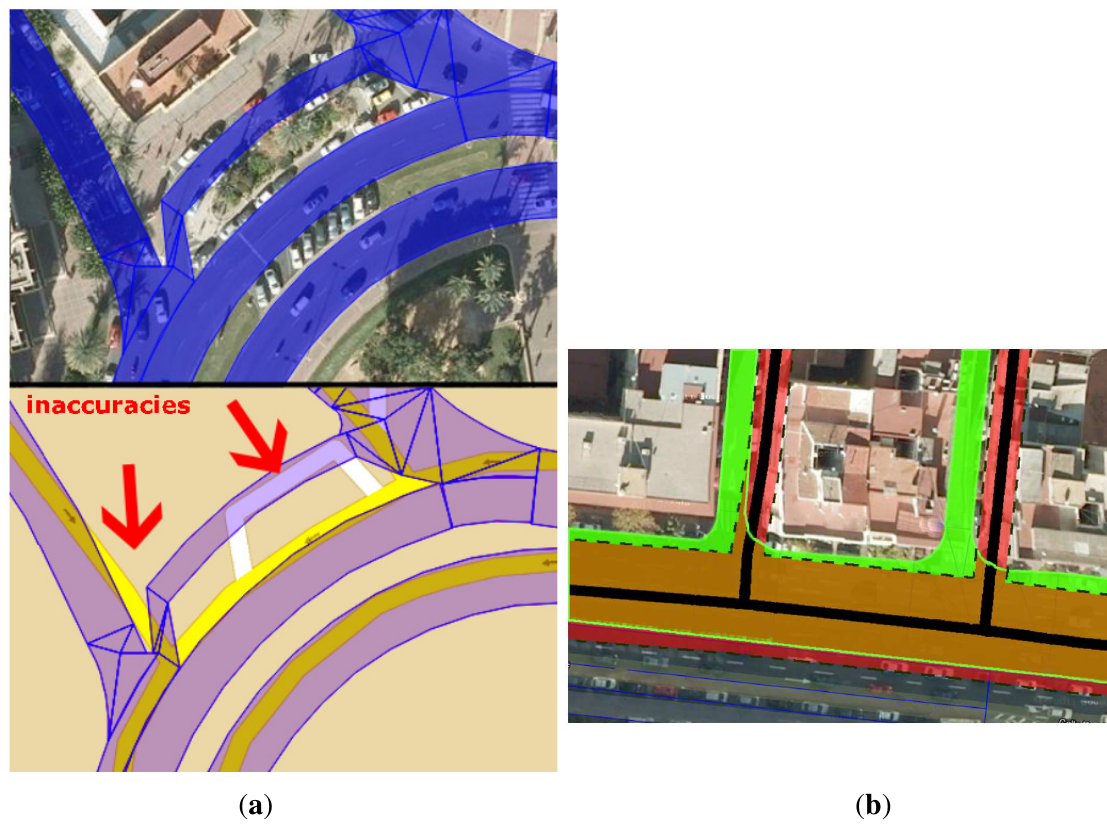
Figure 6. ( a ) Top: aerial view of the scenario under consideration with superimposed EEmap (in blue); Bottom: inaccuracies in the polyline-based map with an overlaying EEmap (in blue). ( b ) Black: centerline of the polyline-based map. The inaccuracies committed in the assumption of a fixed lane-width can be seen (superimposed in red) together with the imprecision of the mid-lane. Black-dash lines show the limit of these lanes. Green: superimposed